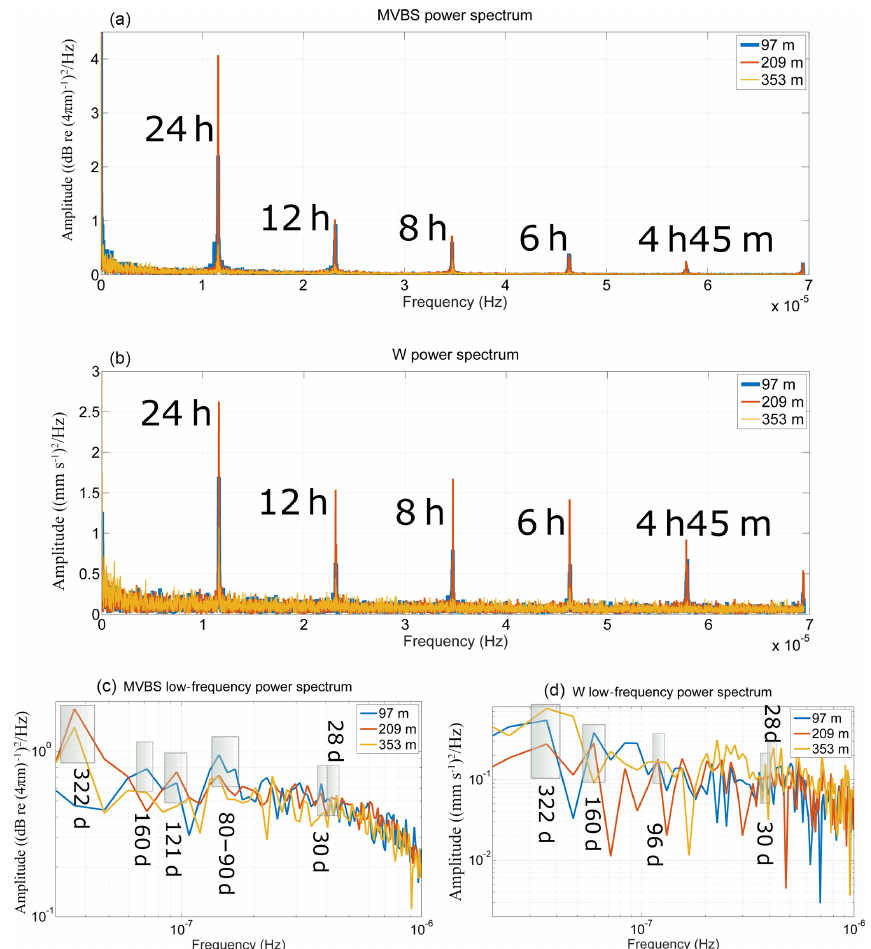
Figure 5. (a) Power spectrum of MVBS (high-frequency range) at three selected bins (97, 209, 353m); (b) same as (a) but for W . (c) Power spectrum of the low-passed MVBS time series (low-frequency range) at three selected bins (97, 209, 353m); (d) same as (b) but for W .